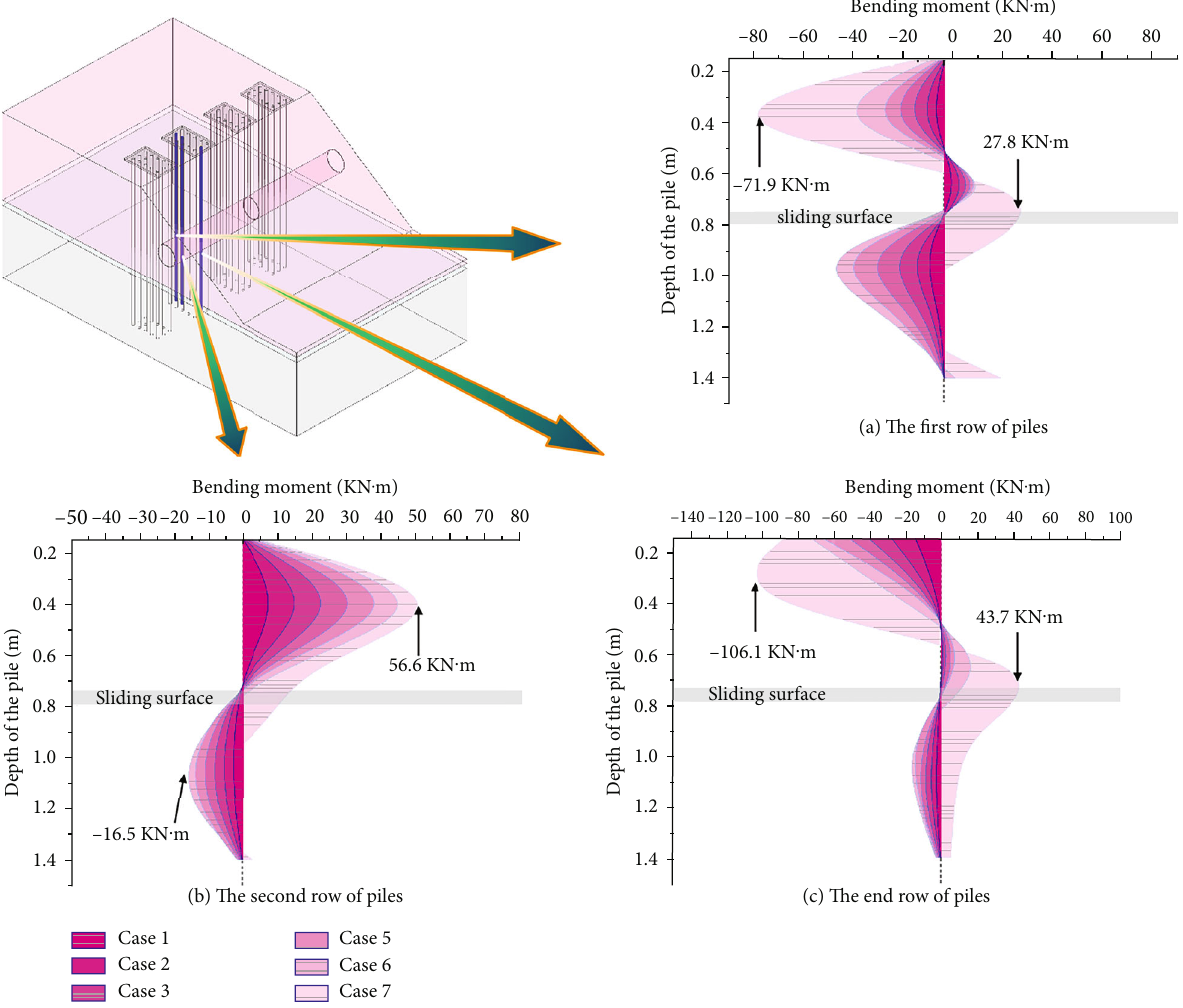
Figure 11: Bending moment distribution of perforated pipe